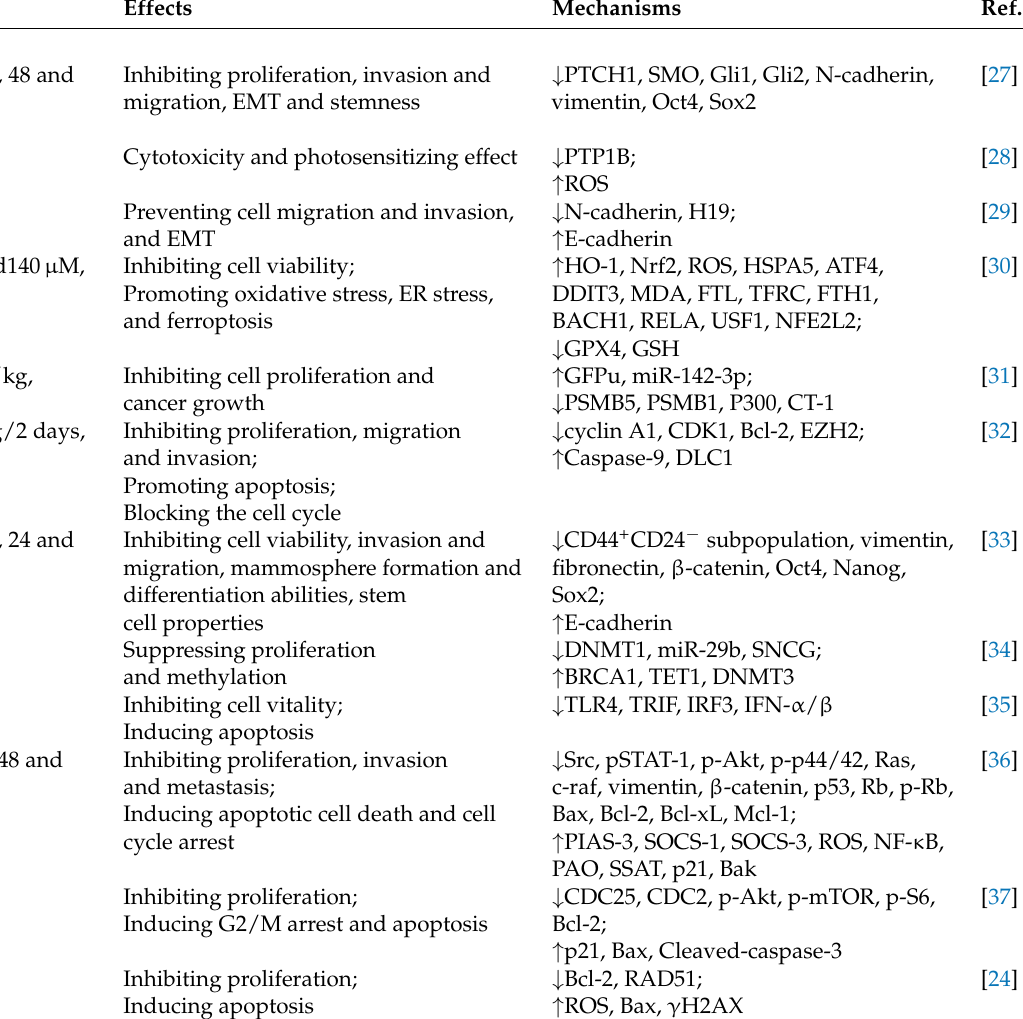
Table 1. The mechanisms of curcumin on